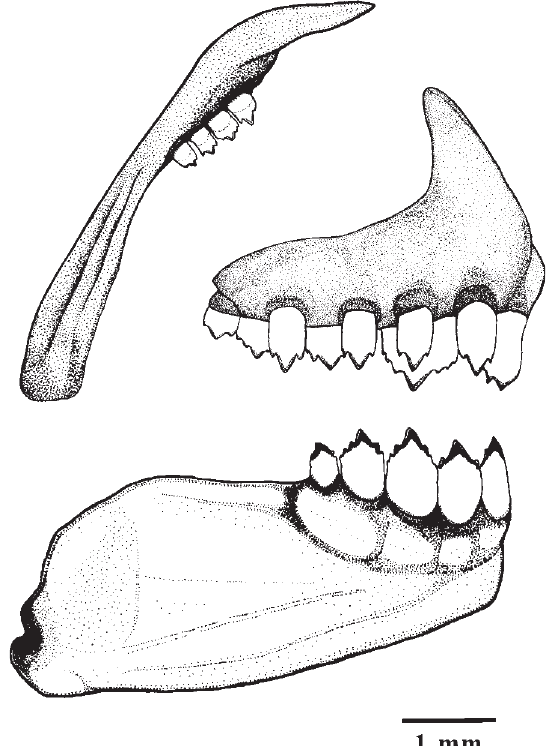
Fig. 3. Astyanax totae , MHNCI 11248, 56.3 mm SL. Maxilla (top-left), premaxilla (top-right) and lower jaw (bottom); lat- eral view; right side; scale 1.0 mm.